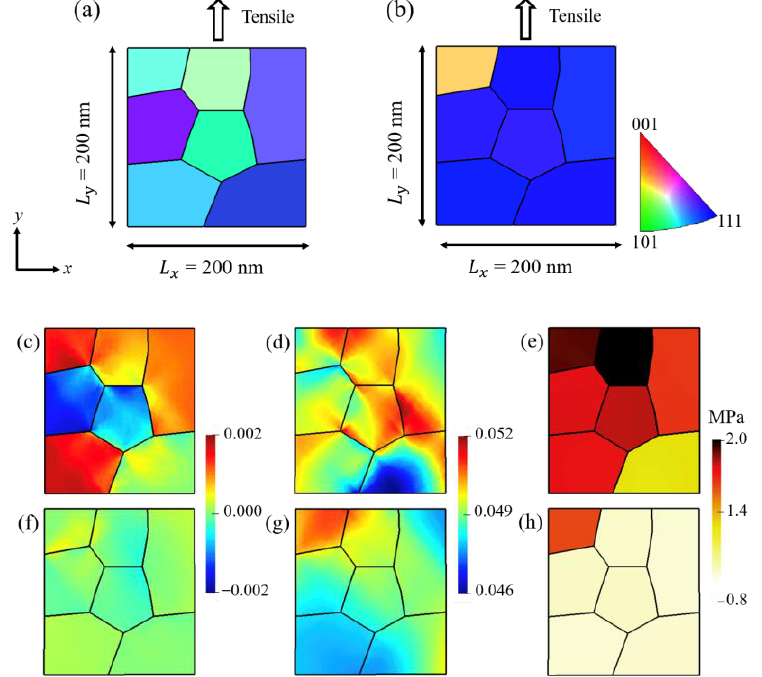
Figure 12. Grain orientations used in the simulations for ( a ) the as-received and ( b ) the trained samples, respectively. ( c – e ) are the contour plots of ε xy , ε yy and the strain energy density of the as-received sample, respectively. ( f – h ) are the contour plots of ε xy , ε yy and the strain energy density of the trained sample, respectively. The applied strain was 5%.